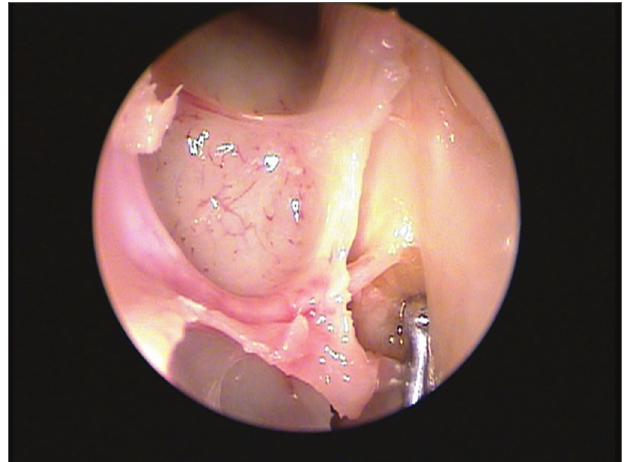
Figura 1. Exposição de artéria etmoidal anterior em plano subperiosteal de órbita esquerda durante a dissecção endoscópica em cadáver (en- doscópio de 45 graus). Pode-se observar trajeto intranasal deiscente em sentido